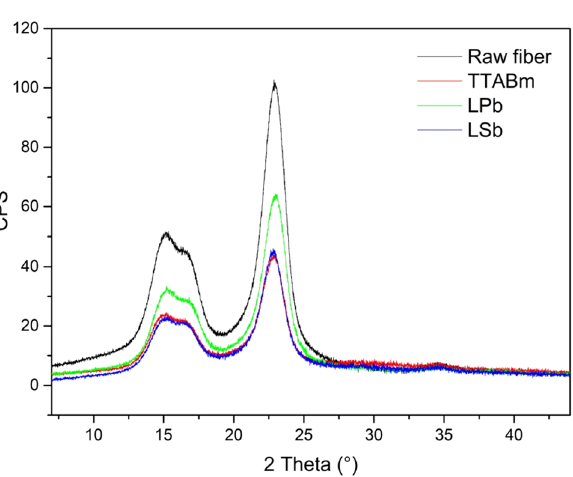
Figure 5. PXRD patterns of the raw fiber, sample TTABm, sample LPb and sample